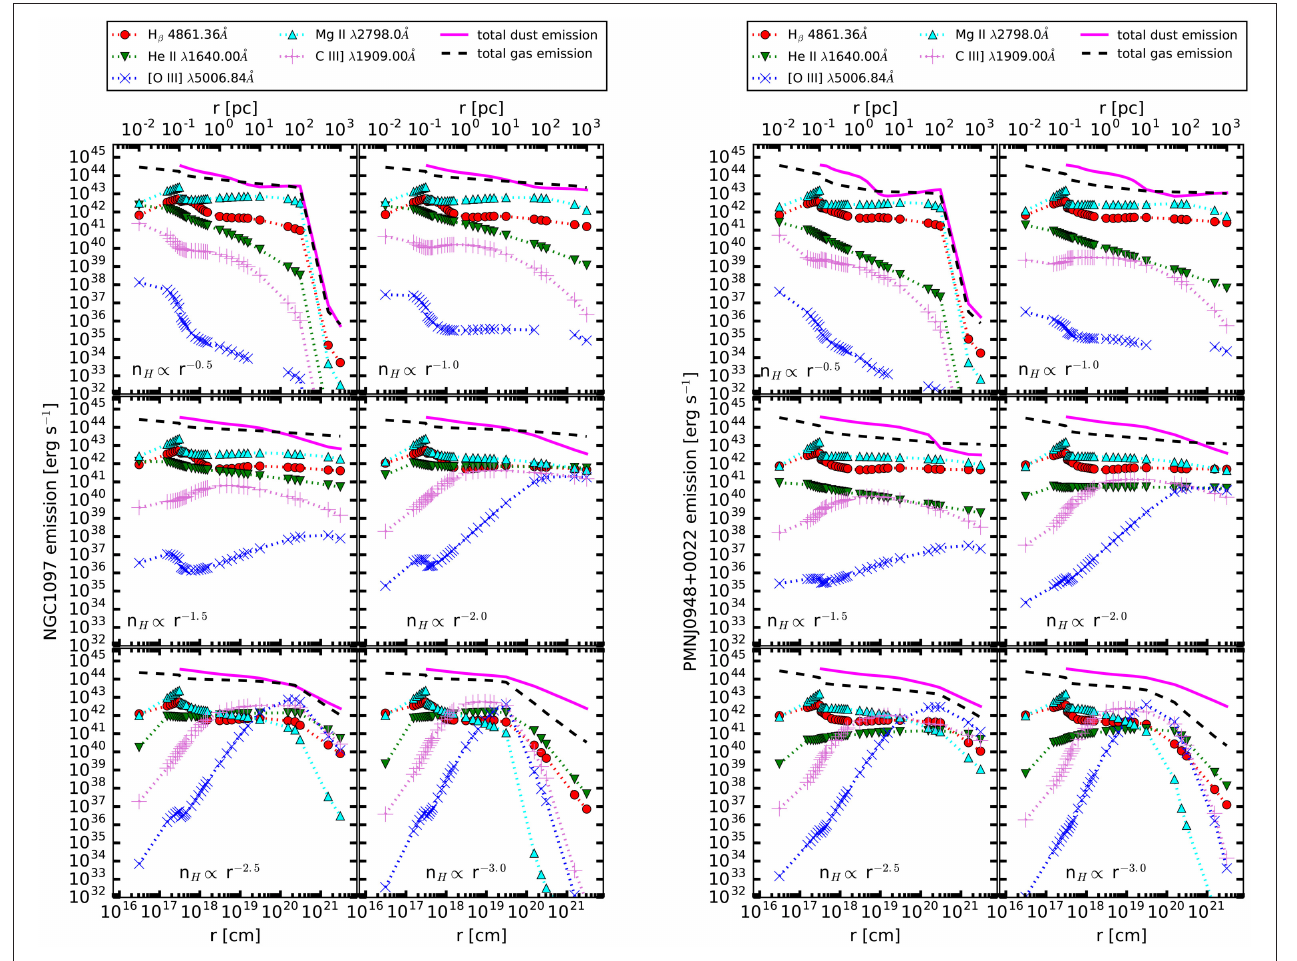
FIGURE 2 | The same as in Figure 1 but for the SED of NGC 1097 (left) and PMN J0948+0022 (right)